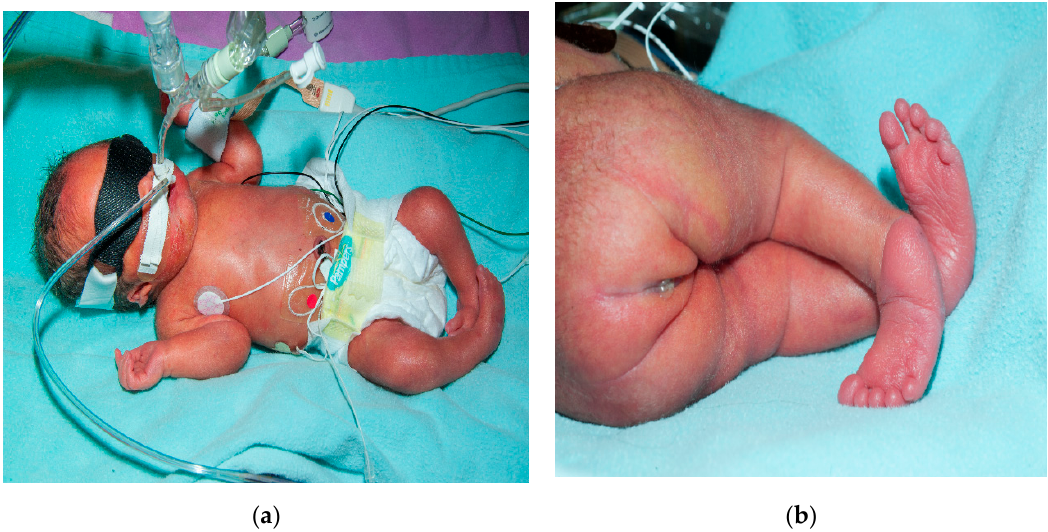
Figure 1. Image depicting club foot, ear, and sacral region anomaly ( a , b ).